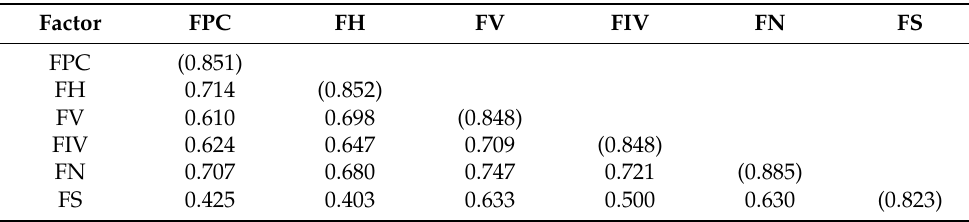
Table 7. Factorial intercorrelations and reliability coefficients (Cronbach’s